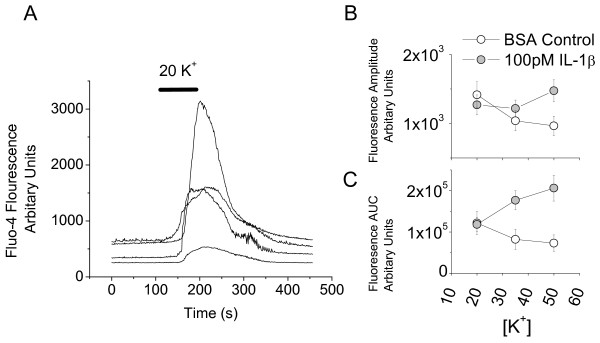
Effects of 6–8 d exposure of the dorsal hornregion of organotypic cultures to 100 pM IL-1β A. Typical time courses of changes in Fluo 4-AM fluorescence, indicating changes in free intracellular [Ca2+] in response to raising [K+] in superfusate from 2.5 to 20 mM. Traces are recordings from somata of cells marked as regions of interest for the analysis software. B and C. Quantification of Fluo-4 fluorescence changes in response to 20, 35 and 50 mM K+ from 26 control and 26 IL-1β treated neurons. Changes in amplitude in response to 50 mM K+ are increased in cytokine-treated slices (p = 0.02). For area under curve (AUC) significant increases are seen for both 35 mM (p < 0.01) and 50 mM K+ (p < 0.001).